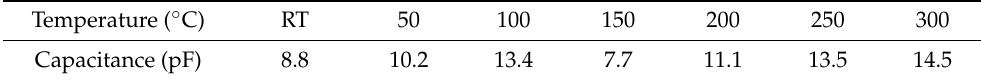
Table 1. Estimation of capacitance from Nyquist diagram.